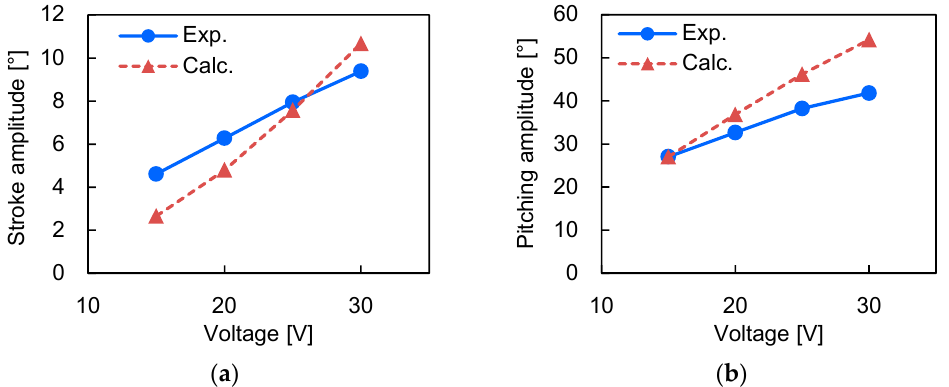
Figure 13. Relationship between applied voltage amplitude and ( a ) stroke amplitude and ( b ) pitching amplitude of small-type actuator. The frequencies of the input signal in the experiment and calculation were 210 and 209 Hz, respectively.